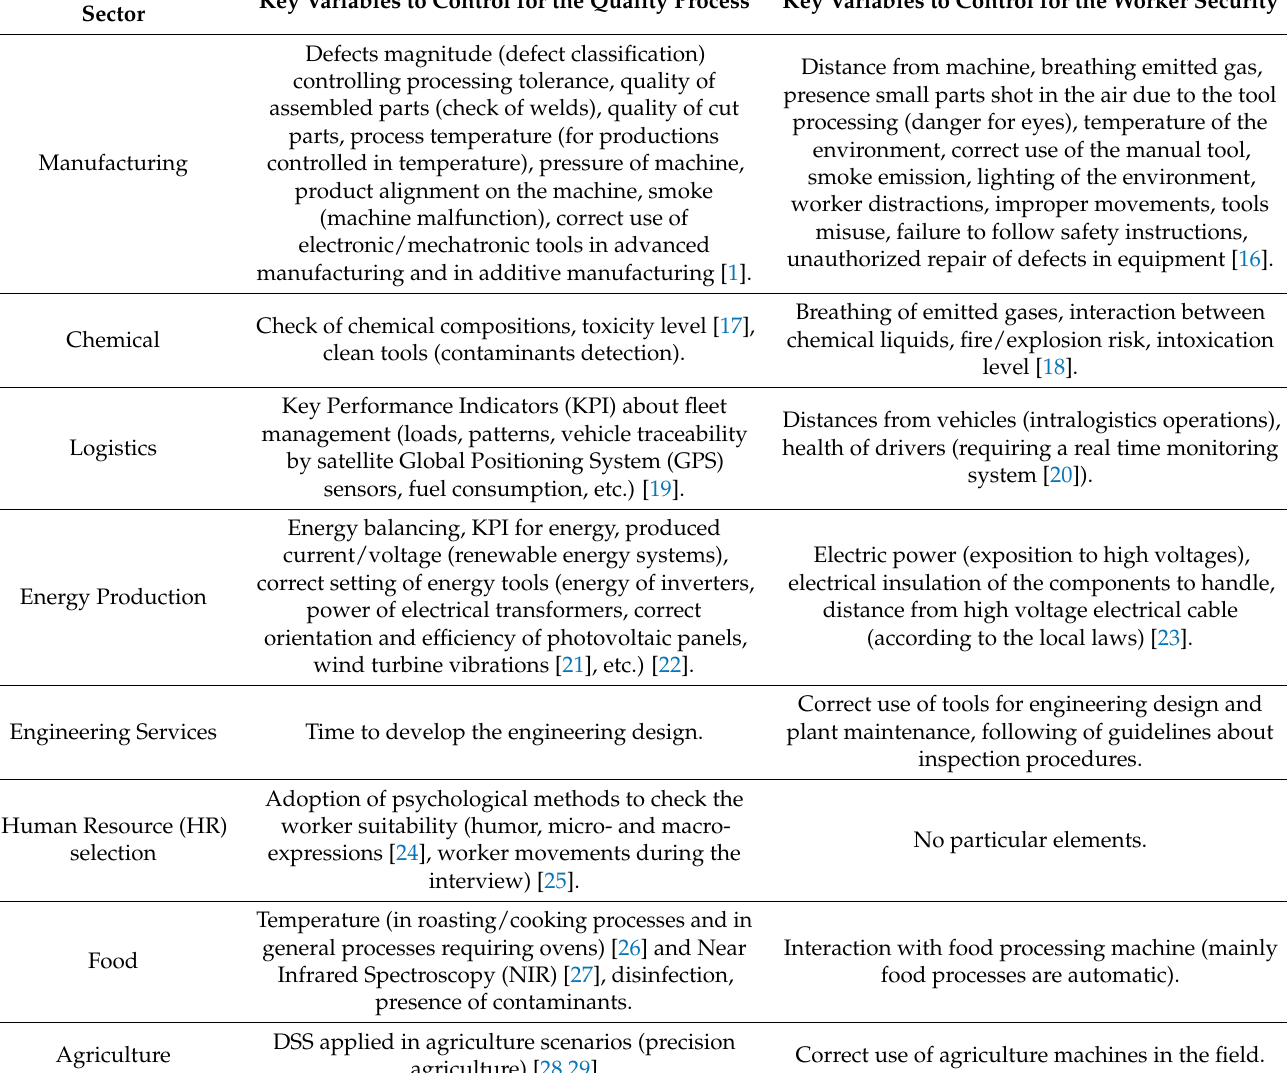
Table 3. Classes of key variables to control production quality and worker